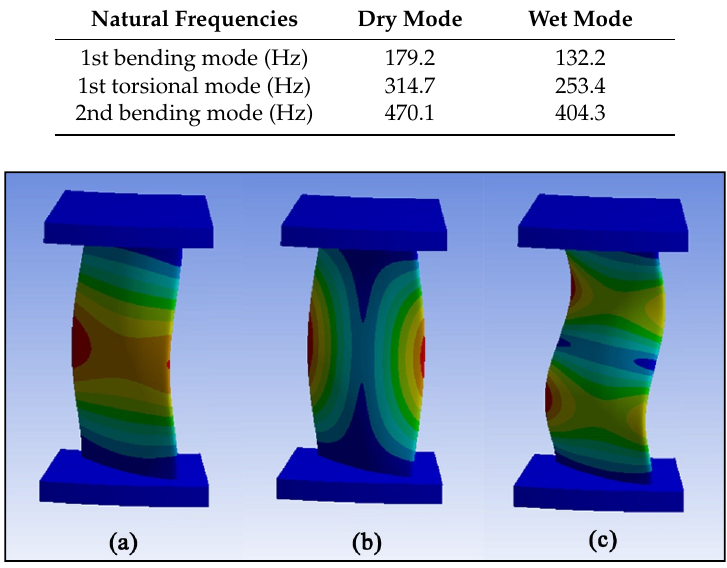
Figure 8. Stay vane mode shapes: ( a ) 1st bending, ( b ) first torsional and ( c ) second bending.